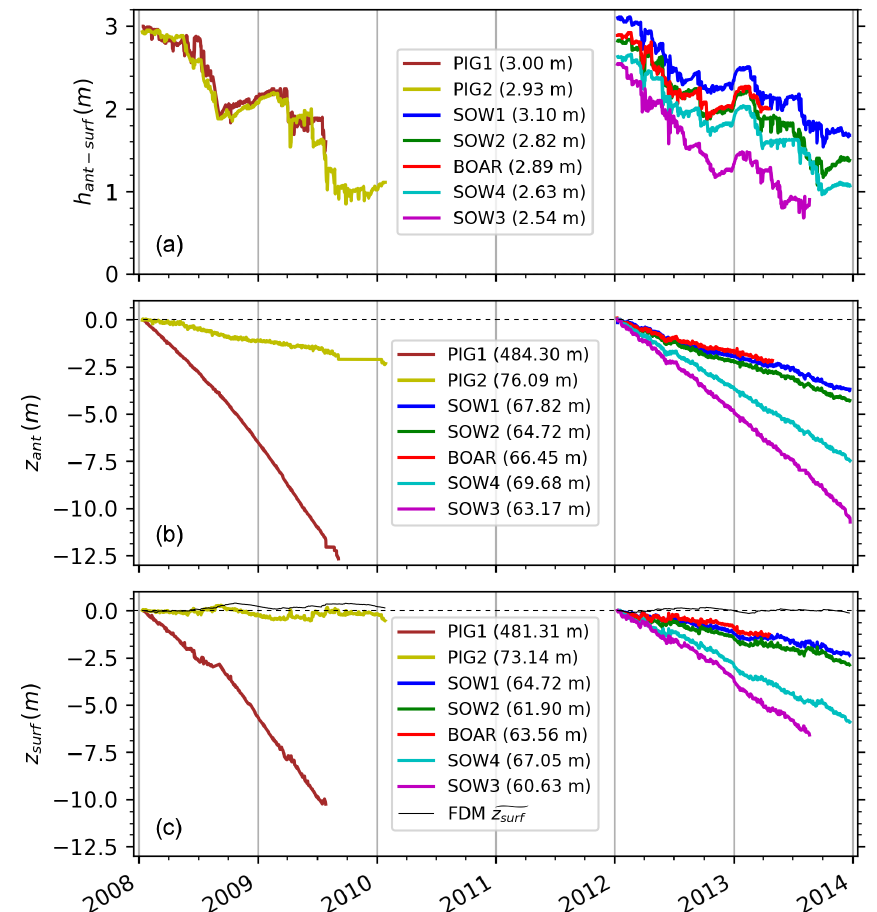
Figure 7. (a) Observed antenna–surface distance ( h ant − surf ) for each station. Legend lists original distance. (b) Observed antenna elevation ( z ant ) relative to initial absolute antenna elevation values listed in legend. (c) Calculated surface elevation ( z surf ) and simulated IMAU-FDM surface elevation from SMB/firn ( g z surf , thin black lines), both relative to initial absolute surface elevation values listed in legend.